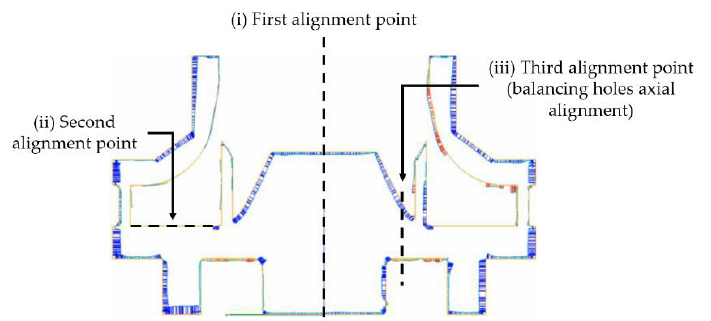
Figure 3. Alignment procedure for the measured model of the closed impeller and the CAD model.